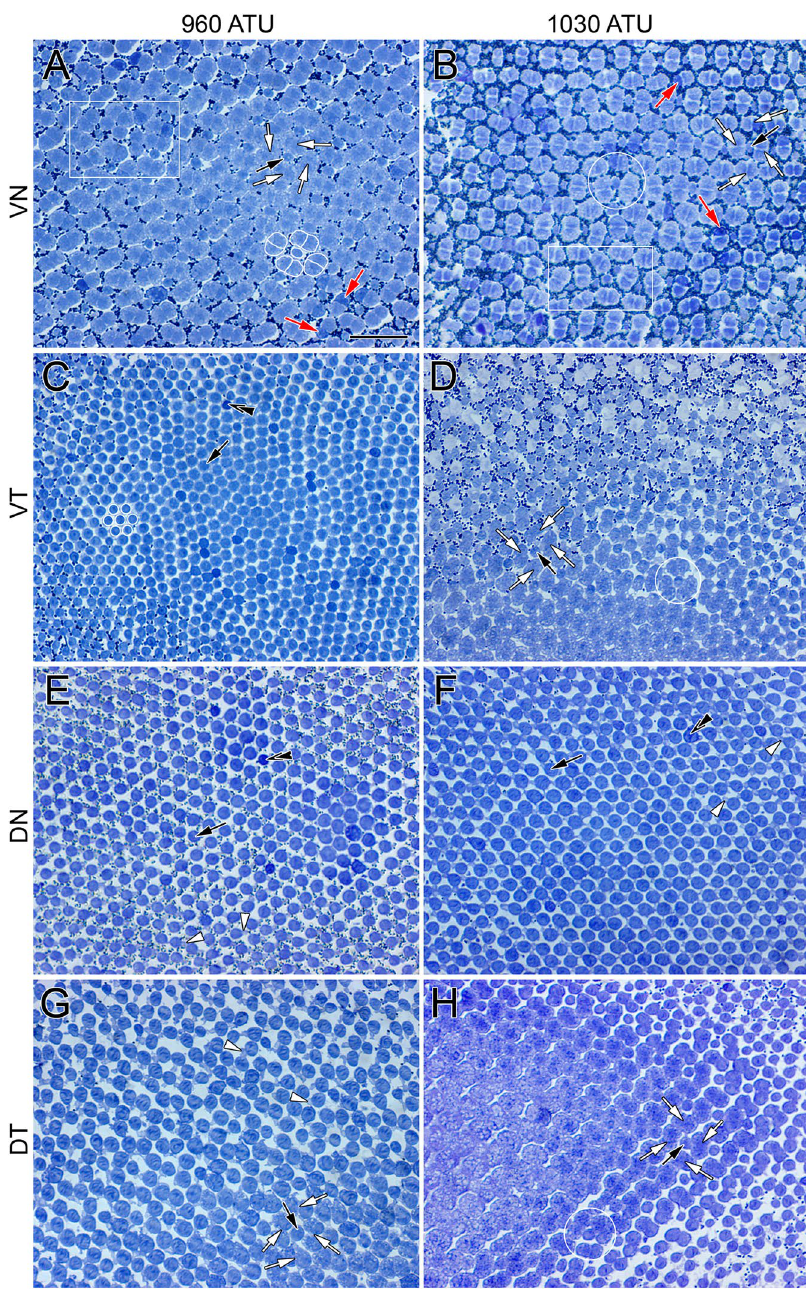
Figure 2. Micrographs of tangential EPON sections showing cone distributions at the level of largest ellipsoid cross section or near the base of the outer segments from various regions of the light adapted retina of Atlantic halibut undergoing metamorphosis. ( A , C , E , G ) Central area from the ventronasal ( A ), ventrotemporal ( C ), dorsonasal ( E ) and dorsotemporal ( G ) retina at 960 ATU. ( B , D , F , H ) Equivalent central sectors to those in ( A , C , E , G ) but from a retina at 1030 ATU. At 960 ATU, the ventronasal ( A ) and dorsotemporal ( D ) quadrants show cone square mosaics whereas honeycomb mosaics characterize the ventrotemporal ( C ) and dorsonasal ( E ) quadrants. ( A ) A square mosaic unit consisting of a single cone surrounded by four double cones is traced in white; white arrows point to the apposing partitions of double cone members surrounding a single cone (black arrow); red arrows indicate double cone members that stain darker than their counterparts. The area within the white rectangle illustrates a less regular arrangement of single and double cones. ( C ) A honeycomb mosaic unit consisting of one single cone surrounded by six others is shown in white; double black arrowheads point to a single cone that stains darker than most others in the field of view. ( E , G ) White arrowheads point to accessory outer segments of individual single cones. At 1030 ATU ( B , D , F , H ), only the central region of the dorsonasal quadrant retains a honeycomb mosaic ( F ). The white rectangle in ( B ) illustrates an area with less regular disposition of single and double cones. ( B , D , H ) White circles encompass a single cone flanked by a triangular arrangement of three neighbouring double cones. Abbreviations as per Fig. 1. Scale bar in ( A ) equals 10 µm and holds for all